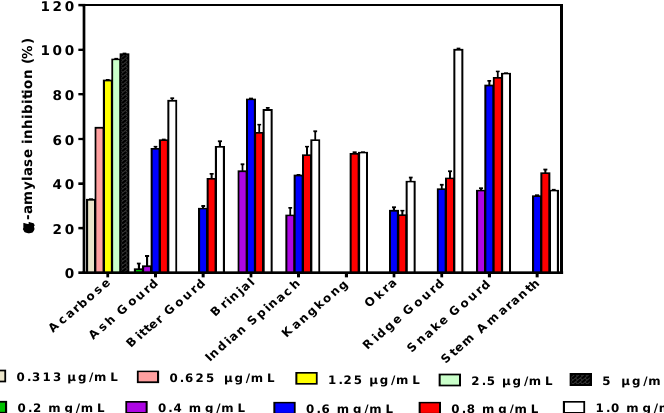
Figure 1. Inhibition of α-amylase activity at different concentrations of acarbose and aqueous polyphenolic extracts of vegetables. Bars are means ( n = 3) ± standard deviation.